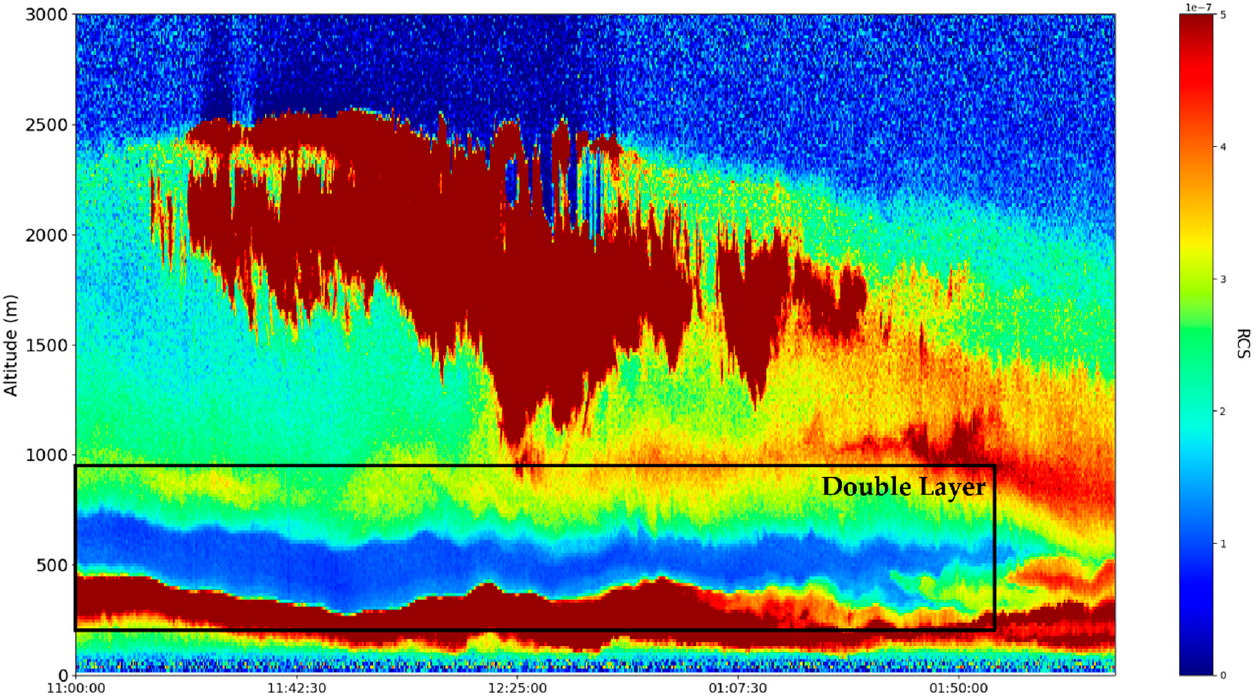
Figure 16. Zoomed-in (region of interest) RCS time series, λ = 1064 nm , Gala ț i, Romania, 22 December 2021.